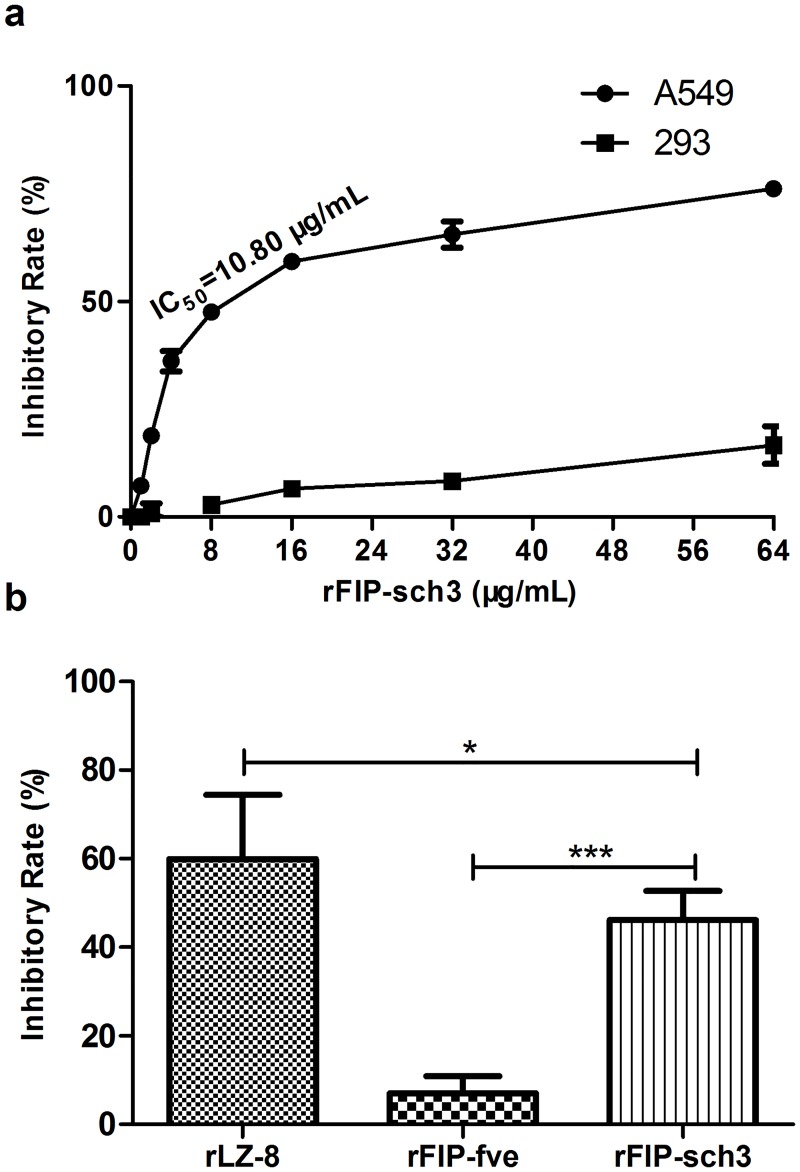
Effect of rFIP-sch3 treatment on A549 and 293 cell viability.(a) A549 and 293 cells were treated with different concentrations of rFIP-sch3 (1, 2, 4, 8, 16, 32 and 64 μg/mL) for 24 h. Cell viability was measured using a CCK assay, and the half-maximal inhibitory concentration (IC50) was calculated using SPSS 19 software. (b) Cytotoxicity comparison between rFIPs in A549 cells. A549 cells were treated with 8 μg/mL rFIPs for 24 h. * p < 0.05, and *** p < 0.001.